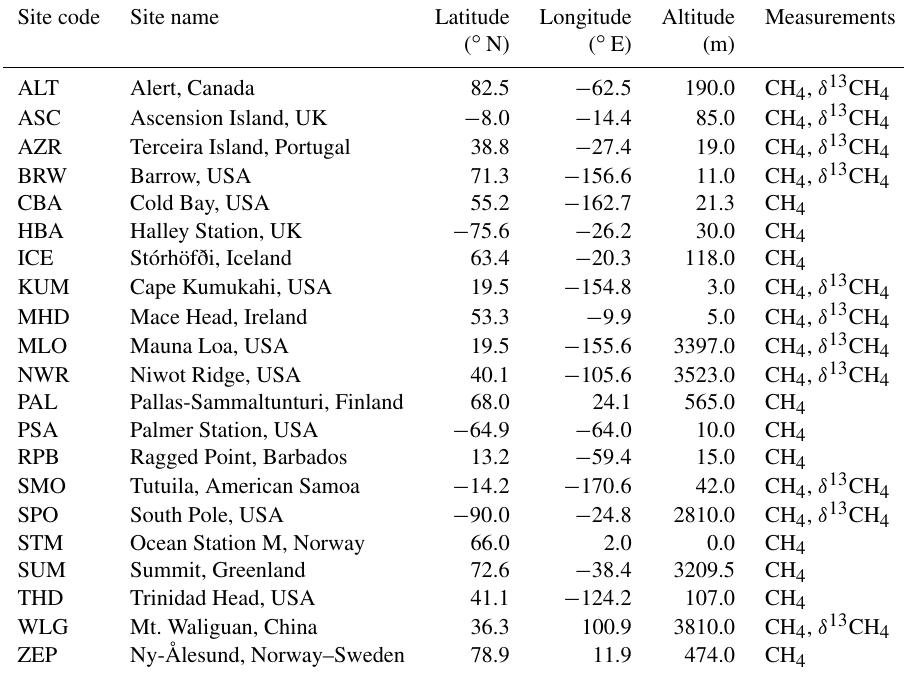
Table 2. NOAA measurements from 2003 to 2015 used in the synthesis inversions of CH 4 (Dlugokencky et al., 2017) and δ 13 CH 4 (White et al.,